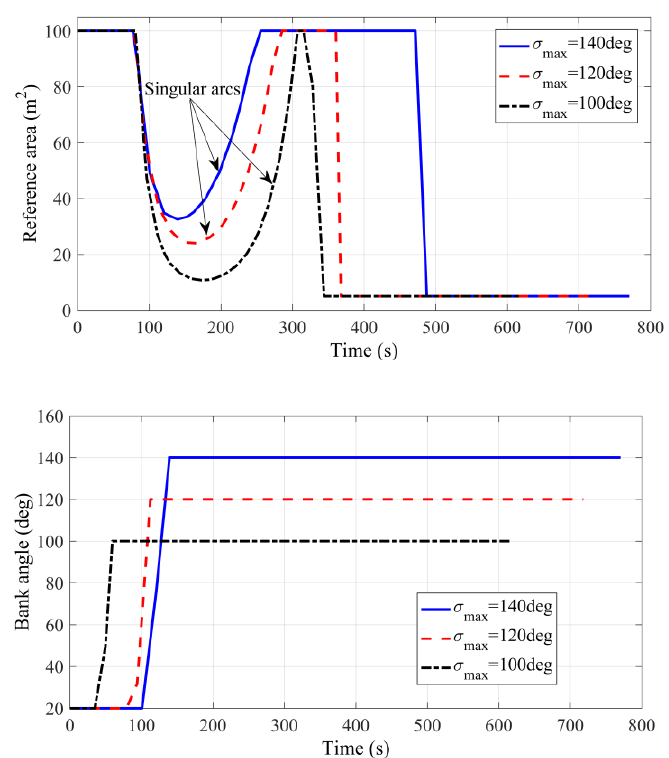
Figure 10. Reference area and bank angle histories with different upper bounds in terms of the bank angle.